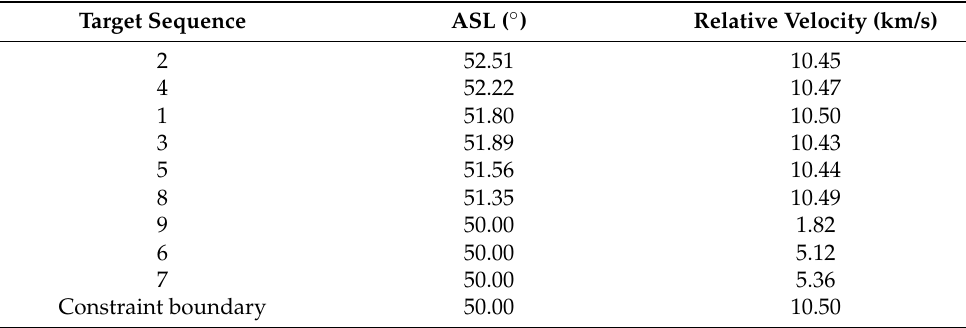
Table 6. Constraint values of each inspection task of example 2.